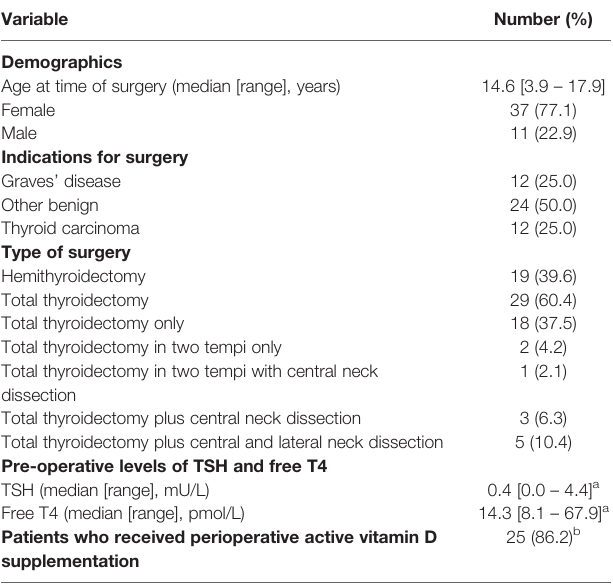
TABLE 2 | Demographic, clinical and surgical characteristics of 48 included